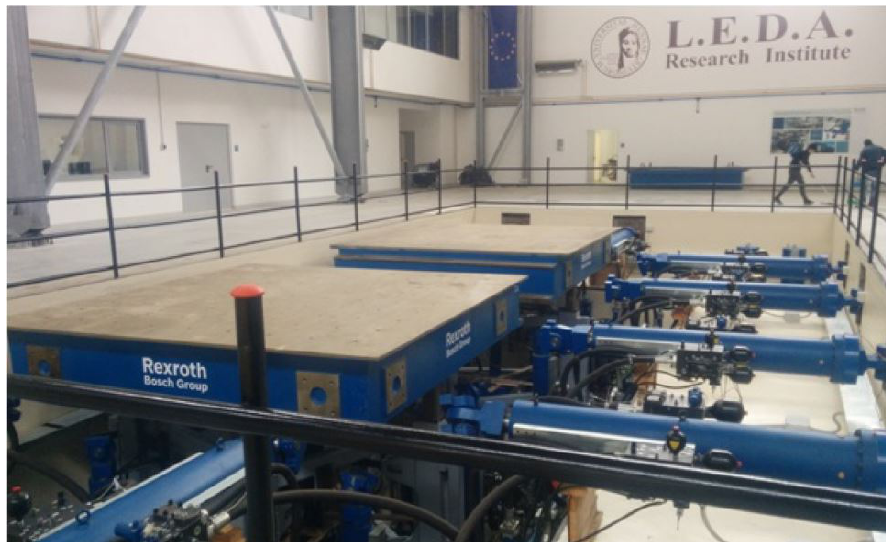
Figure 17. Photographic view of the shaking tables system (From [62]). Table 2. Features of LEDA shaking tables (From [62]).